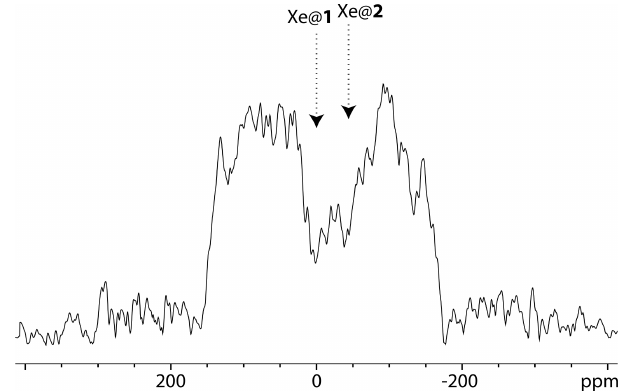
Figure 6. 129 Xe UFZ spectrum of the noble gas into the solution containing the cryptophane mixture at 1T and 295K, using the same pulse sequence as for Fig. 5, except that the saturation gra- dient is opposite: G sat = − 21mTm − 1 ; G acq = 84mTm − 1 . Satu- ration delay: